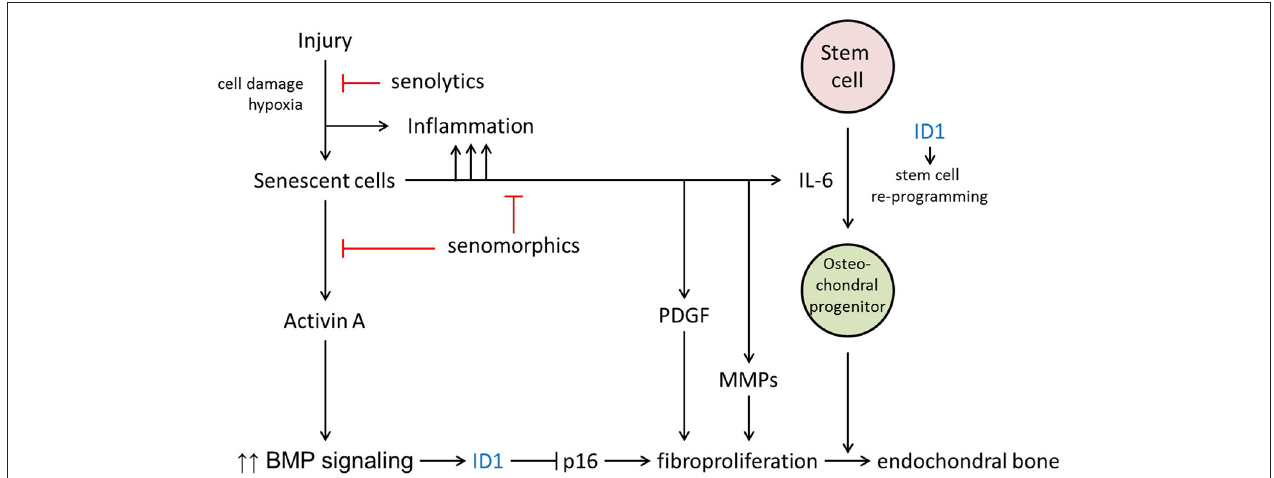
FIGURE 2 | Potential roles for cellular senescence in FOP lesion formation. The major hypothesized contributions of senescence are through the production of activin A, IL-6, and other components of the SASP. T , inhibitory pathways; T , inhibitory action of senotherapeutic